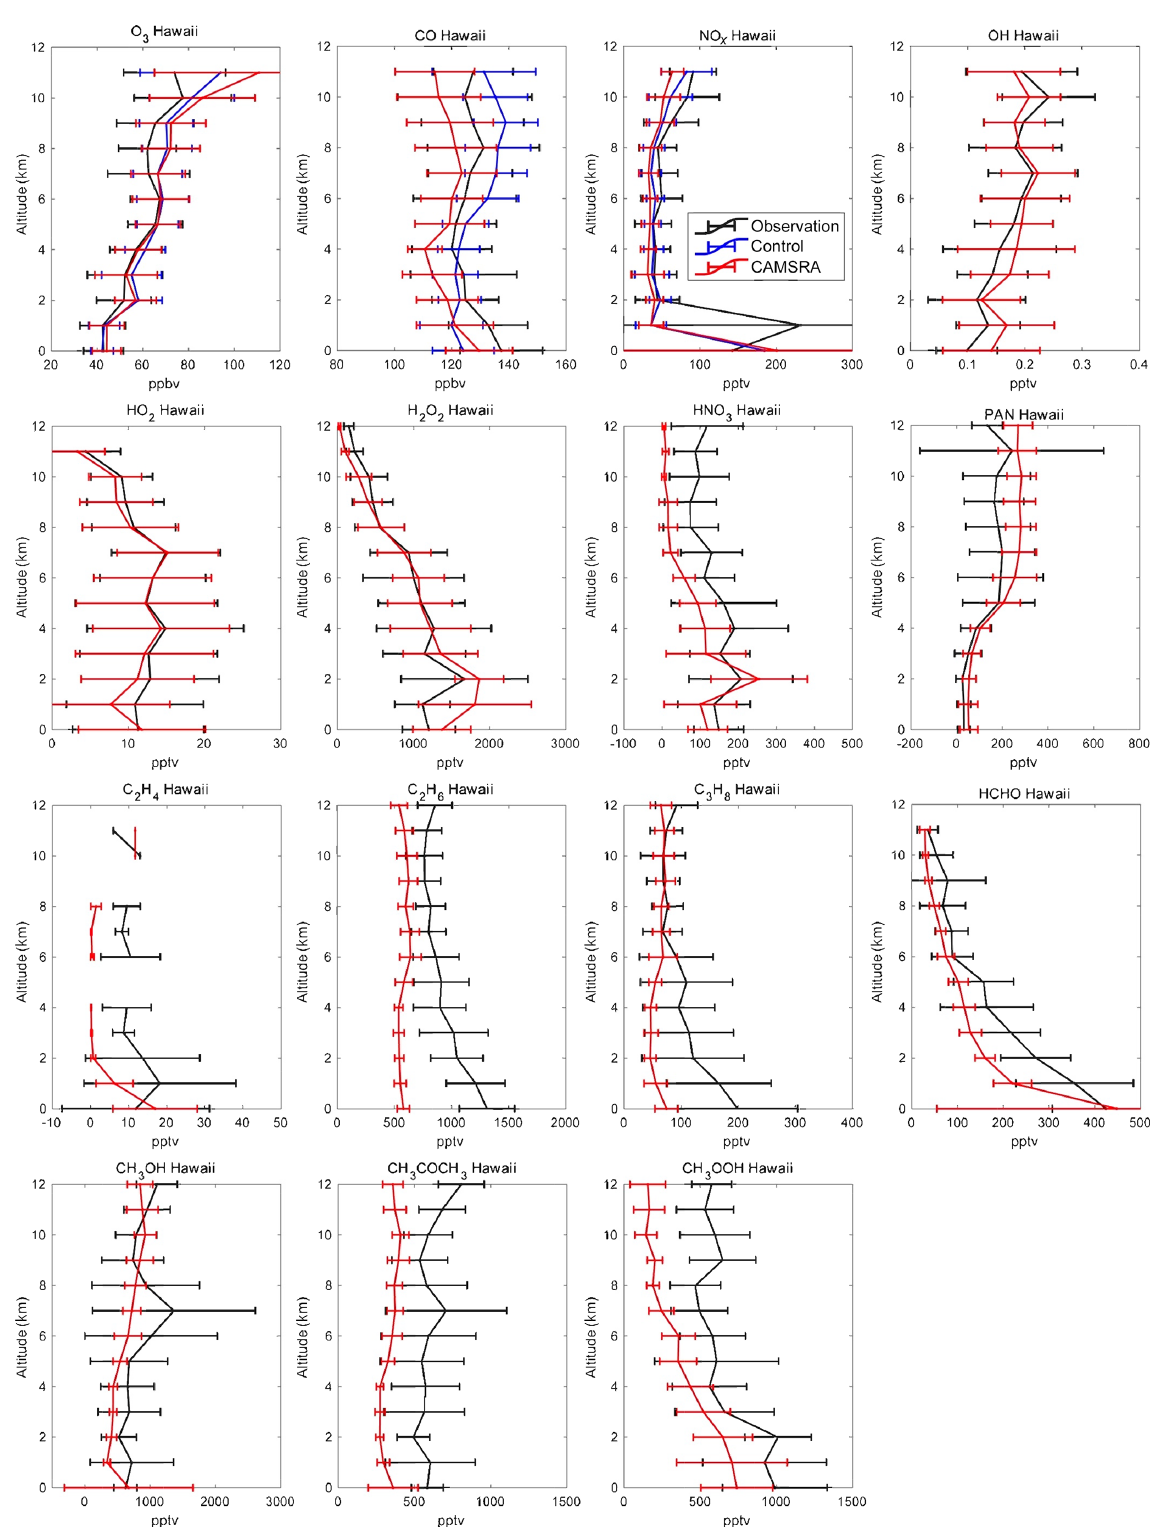
Figure 11. Averaged profiles of the trace constituents over Hawaii during the INTEX-B campaign from March to May 2006. The black lines are the observations, the red lines correspond to the CAMSRA reanalysis, and the blue lines are the control run (only shown for O 3 , CO and NO x ). The error bars represent the standard deviation of the data and